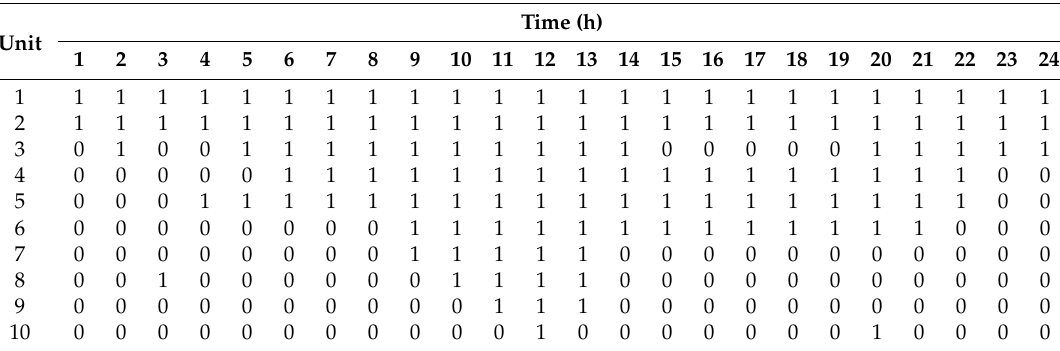
Table A2. Unit State Combination of Stc2.